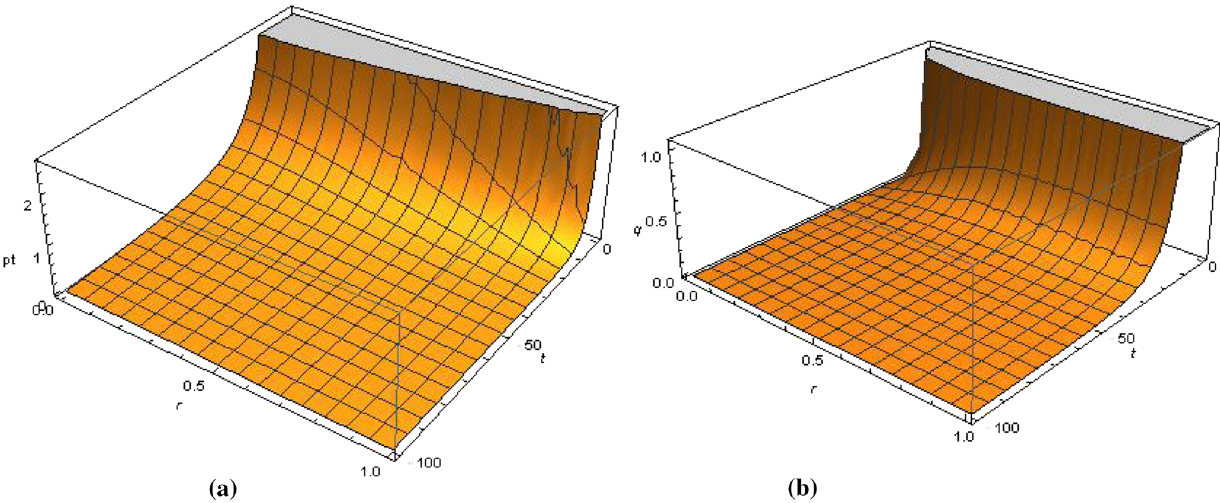
Fig. 2 a Plot of the tangential pressure p t , Eq. (2.50), with respect to r at center r = 0 and at the surface of the star at r = 1. This plot shows that the tangential pressure is also positive as the collapse starts at t = − 100 and is maximum at the end state of the collapse at t = 0. b Plot of the radial heat flux q , Eq. (2.51), withrespect to t and r . This plot shows that the heat flux is positive, implying heat is radiating through-